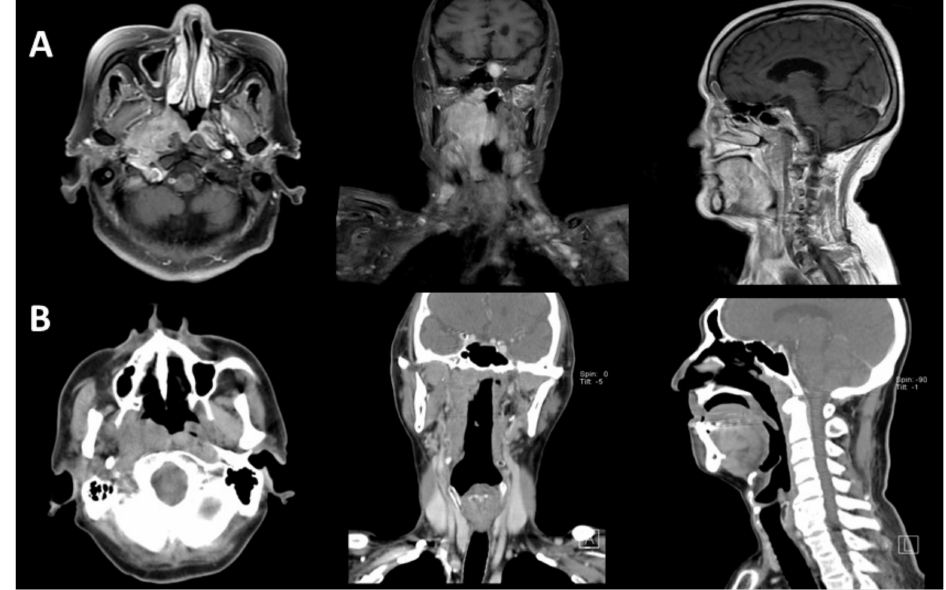
Figure 2. MRI and CT images of NP lymphomas. ( A ) An 85-year-old female diagnosed with NP DLBCL. The MRI revealed that the tumor involved the right NP and right parapharyngeal space. ( B ) A 73-year-old male diagnosed with NP NKTCL. The CT scan revealed that the tumor involved the right